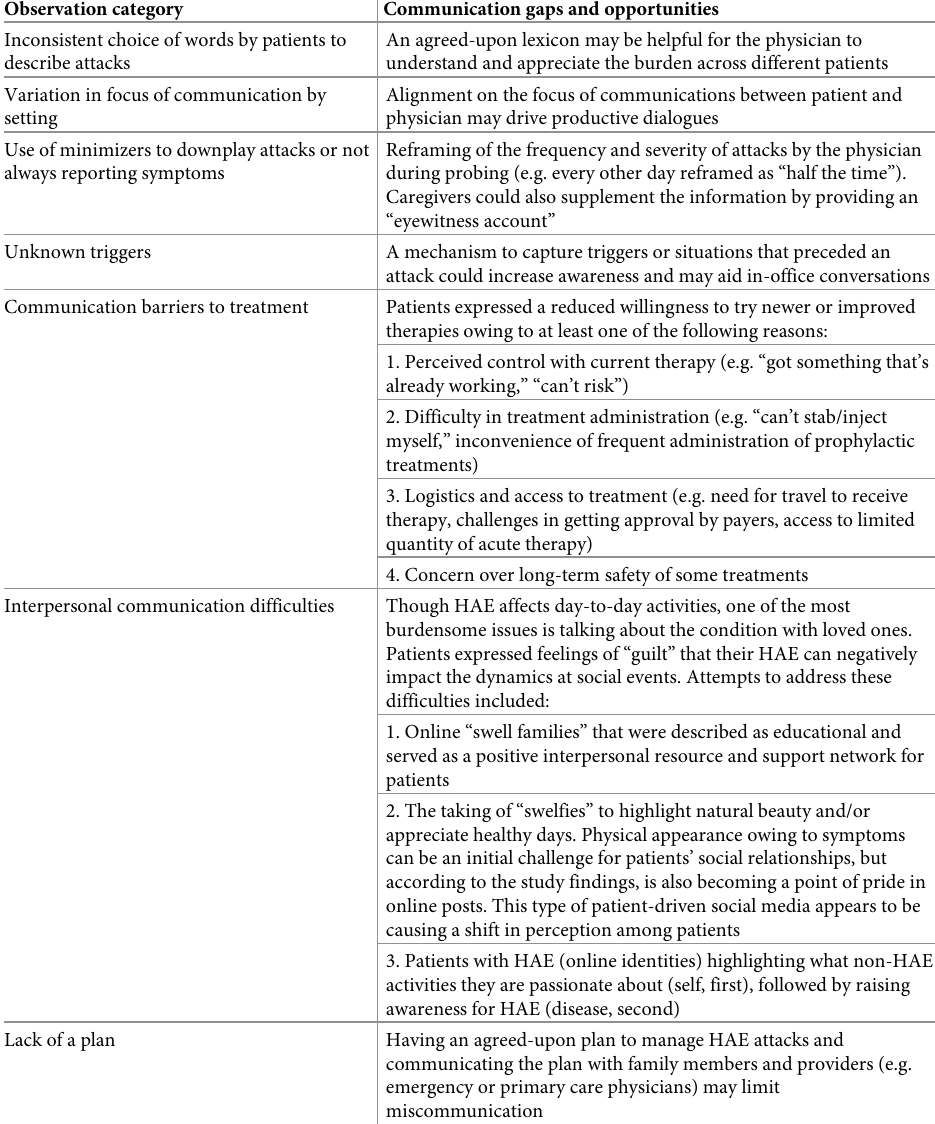
Table 4. Observations of communication gaps and opportunities to improve patient–physician communication regarding